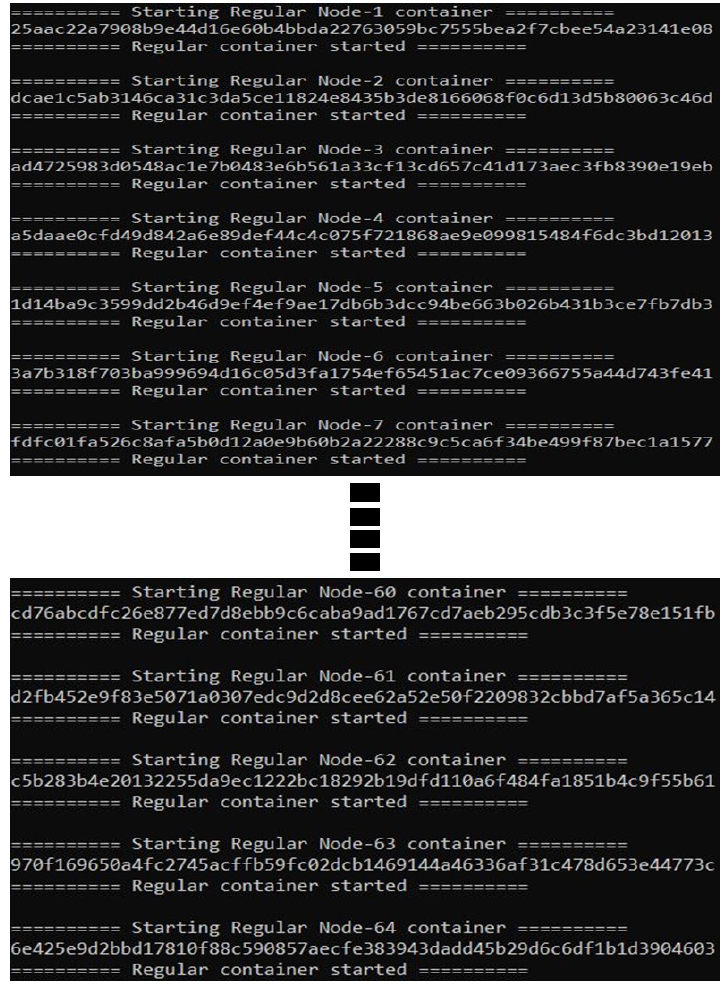
Figure 8. The 64 FlexiChain Nodes Registered.